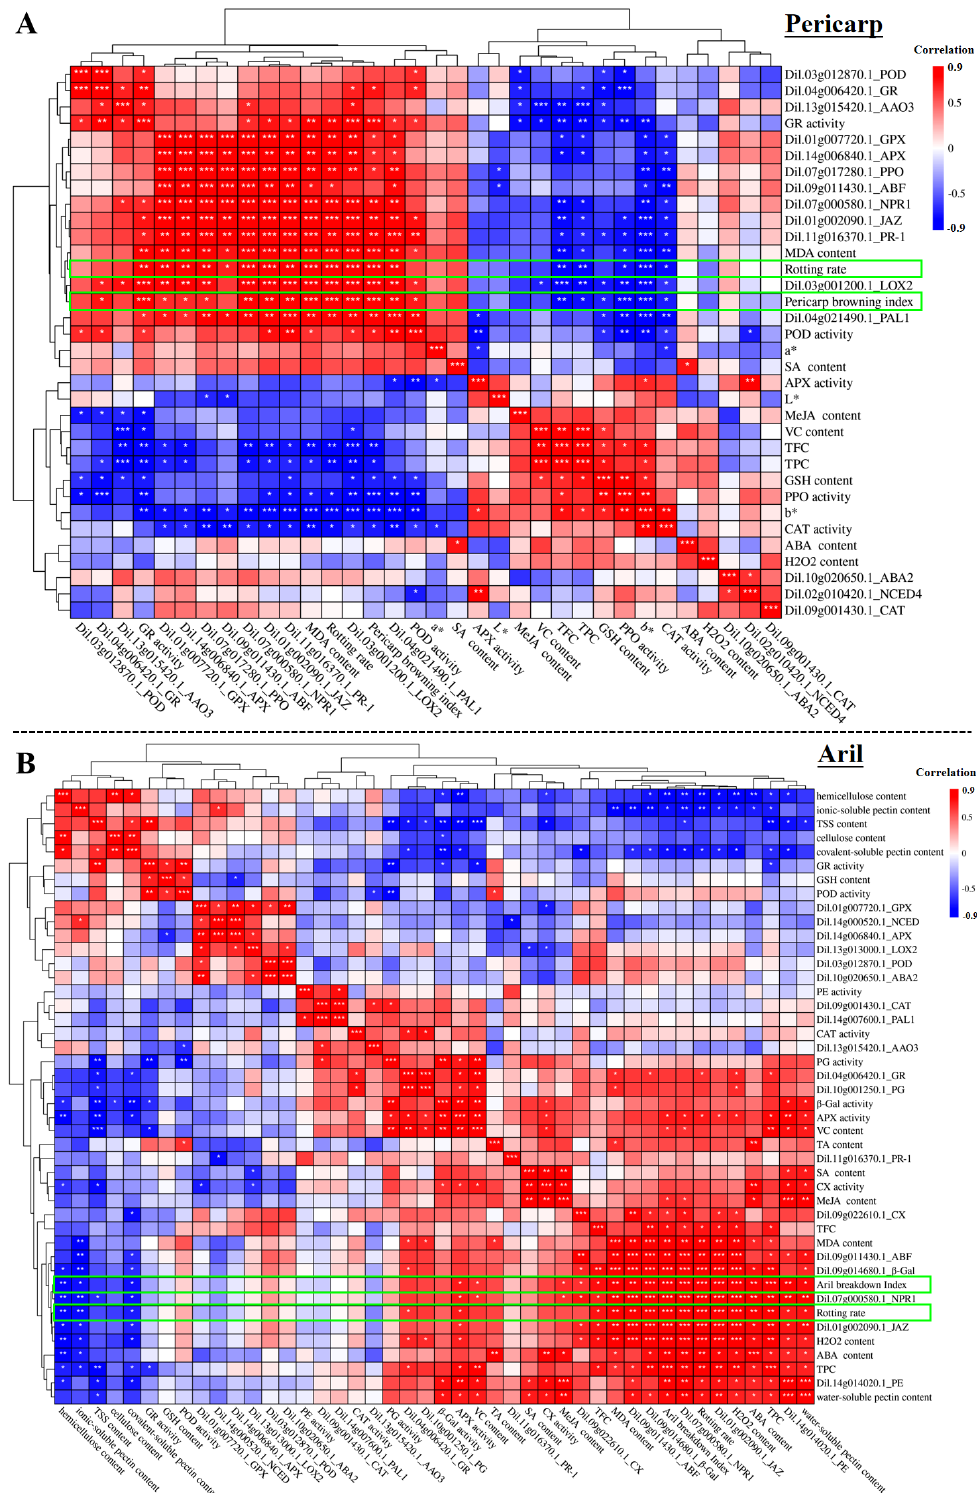
Figure 6. The correlation of physiological parameters, enzyme activities and gene expression with the pericarp browning ( A ) and aril breakdown ( B ). Color gradation: red means positive correlation and blue means negative correlation. The green box marked the correlation of aril breakdown and rooting rate with the other parameters. *: 0.01 < p < 0.05: **: 0.001 < p < 0.01; ***: p < 0.001.